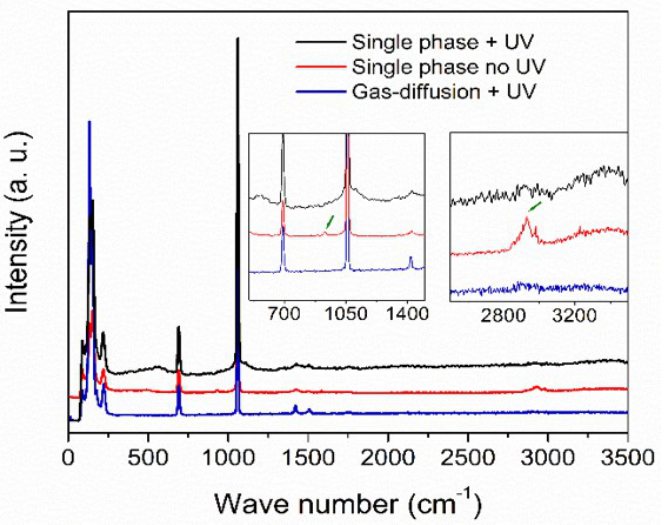
Figure 6. Raman shifts from BaCO 3 precipitates growth with PA [0.1 M]. Blue line: gas-diffusion setup under UV radiation. Red line: Single-phase setup without UV radiation. Black line: single-phase setup under UV radiation.